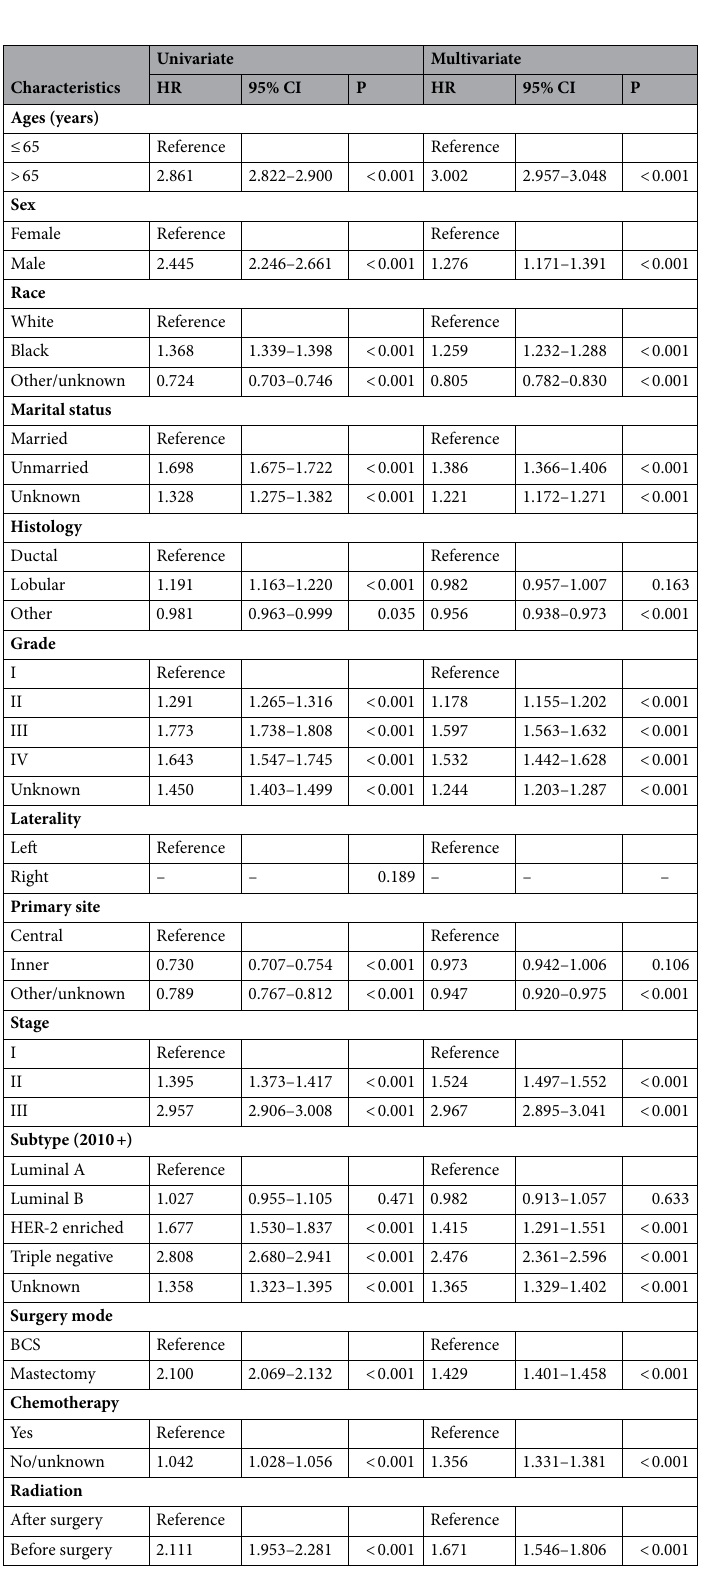
Table 2. Univariate and multivariate Cox regression of overall survival in the whole